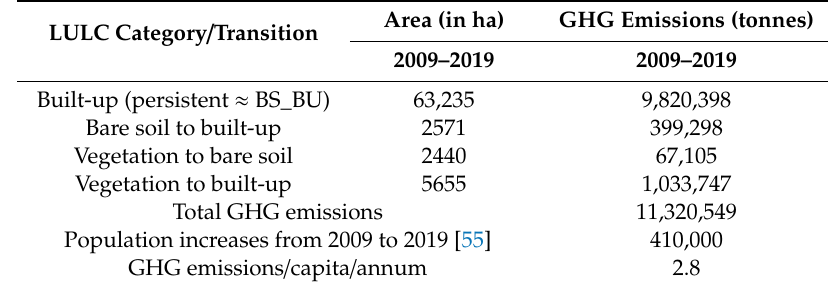
Table 10. Calculating Brisbane’s GHG emissions that originated from the persistent built-up area category and major LULC